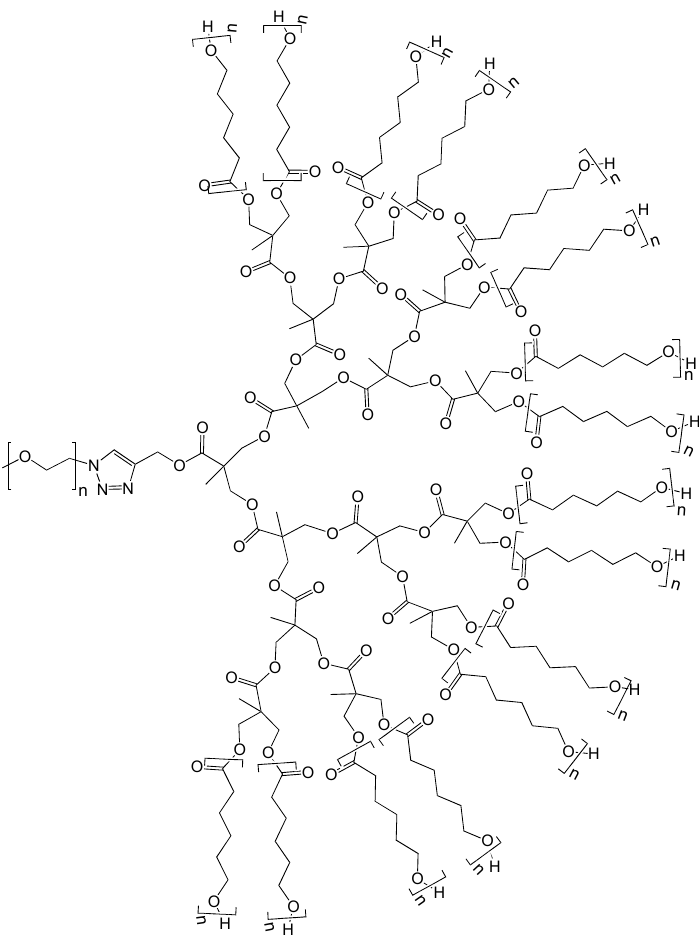
Figure 4. 2,2-bis-(hydroxy-methyl) propionic acid-based dendrimer, functionalized with poly( ε - caprolactone) chains at the termini, and PEG at the core [166].